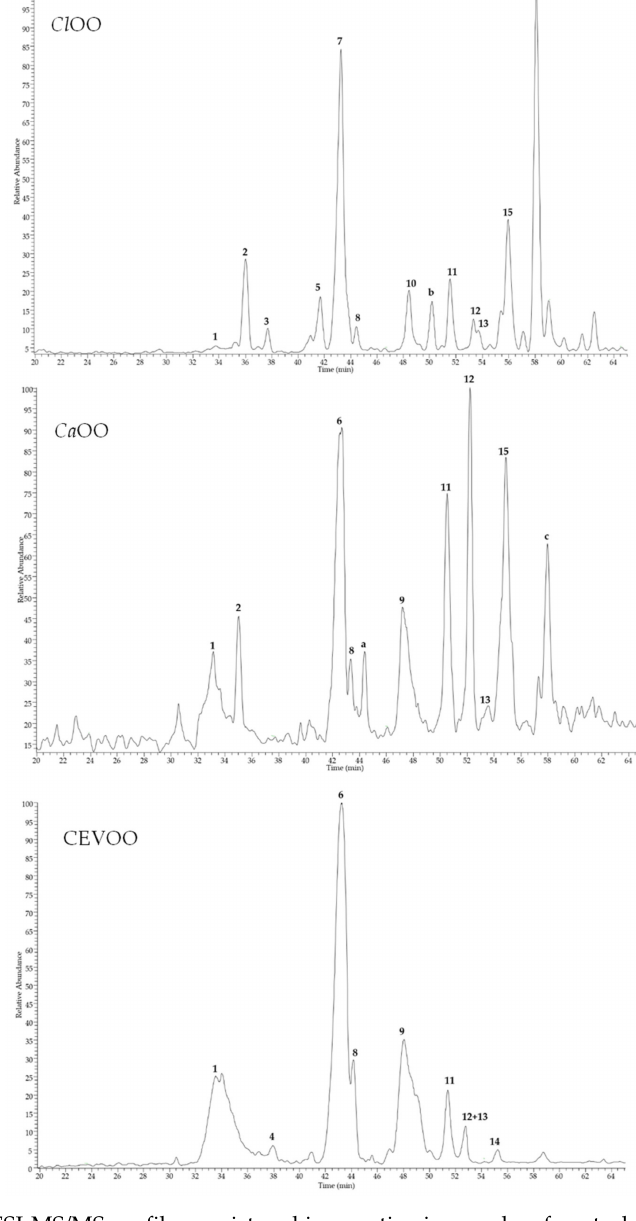
Figure 2. HPLC-ESI-MS / MS profiles, registered in negative ion mode, of control (CEVOO), Citrus x aurantium peel ( Ca OO), and Citrus limon peel ( Cl OO) olive oil extracts. Data of peaks 1–16 are listed